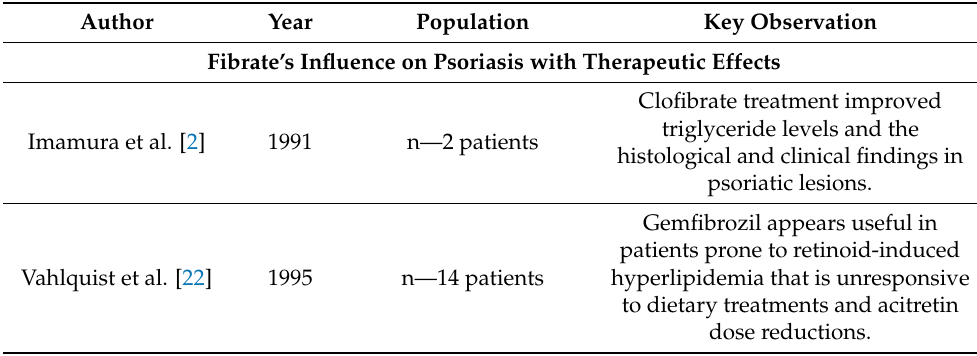
Table 6. Summary of the studies on fibrate’s influence on psoriasis with therapeutic